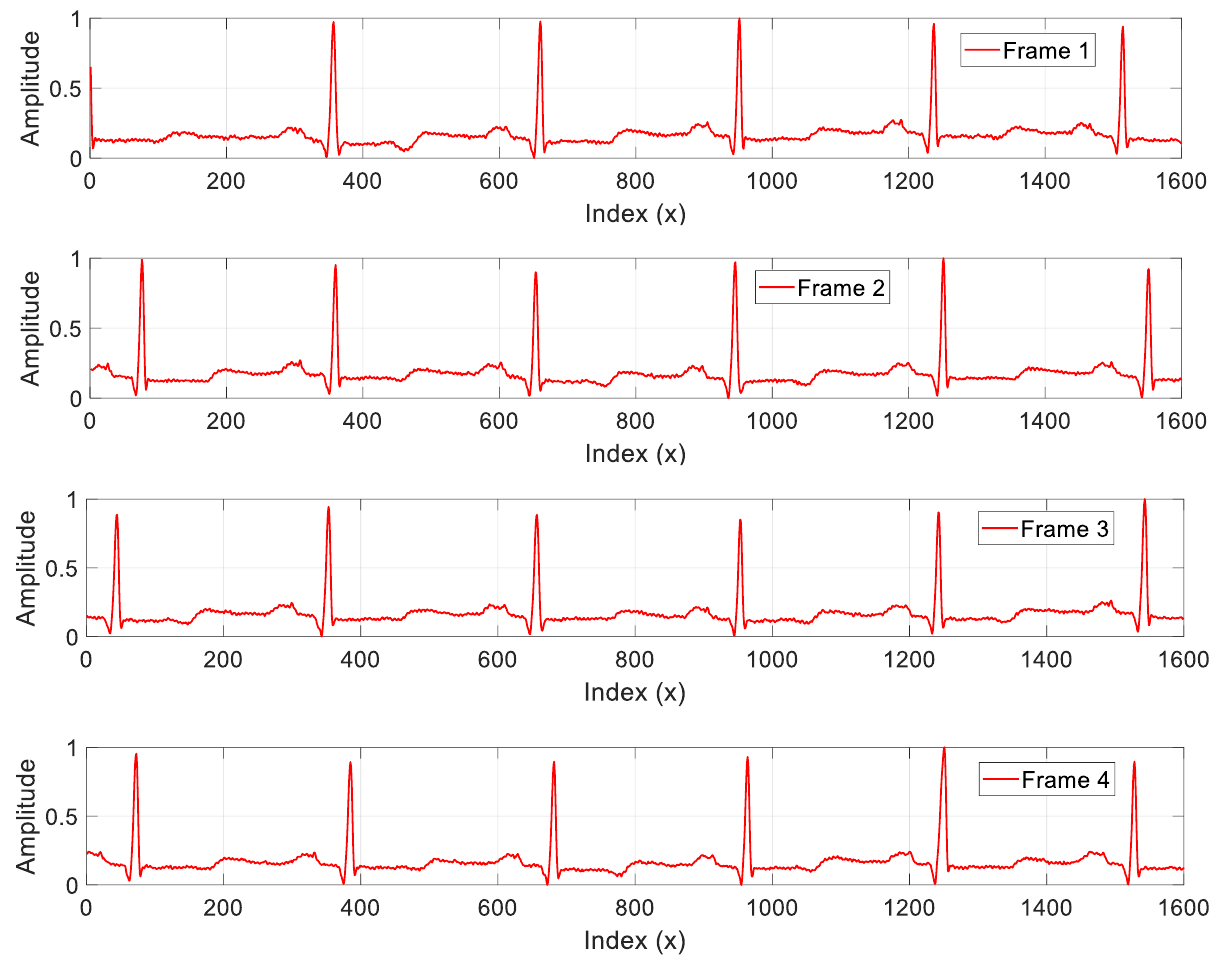
Figure 10. Four test frames, each of size L = 1600, of ECG signal named “Record_100” that was selected from dataset presented in [41].